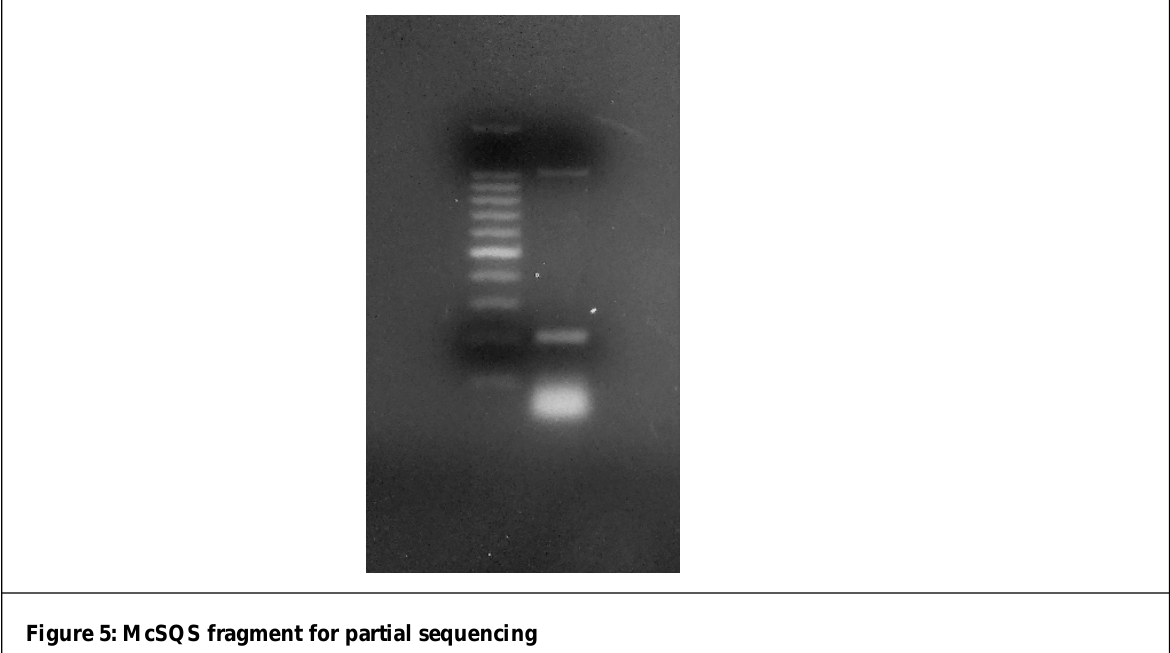
Figure 5: McSQS fragment for partial sequencing